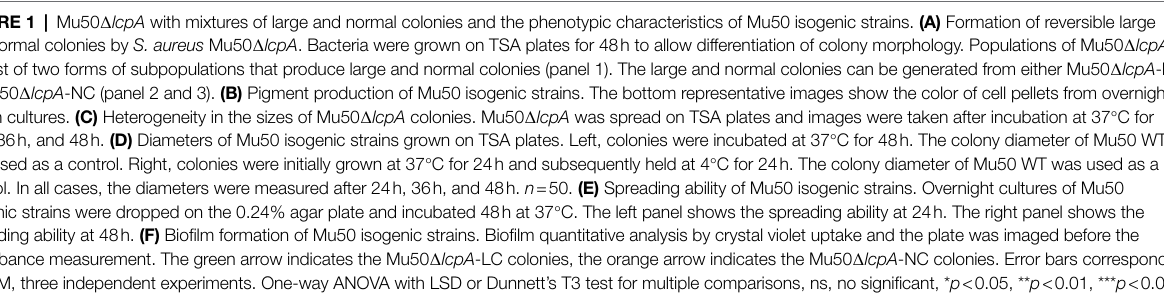
TABLE 1 | β -lactam MICs ( μ g/ml) of wild-type and lcpA mutant strains. MIC ( μ g/ml) Strains Oxacillin Cefazolin Penicillin BA01611